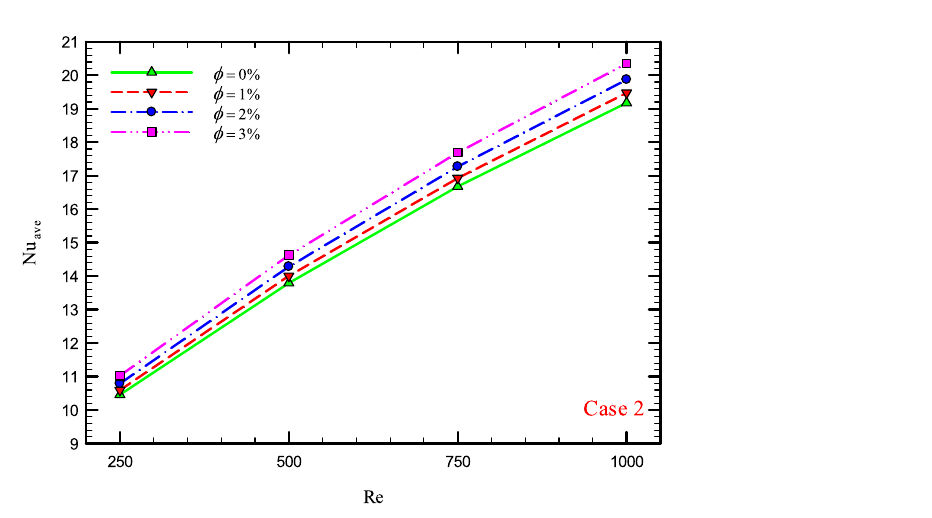
Figure 10. Nu ave versus Re for Case